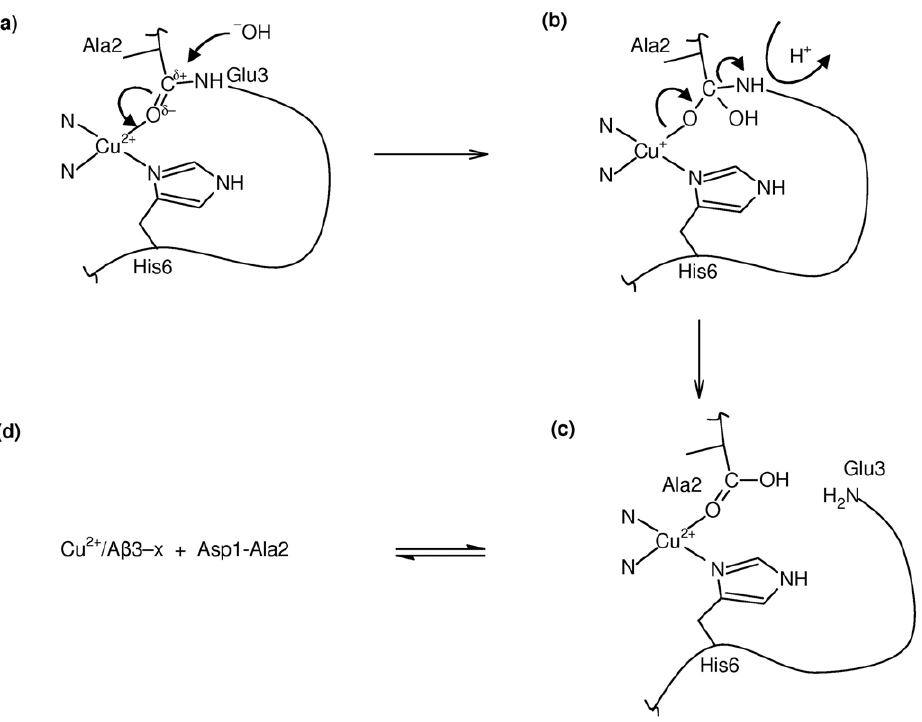
Figure 8. Postulated mechanism of Cu 2 + -promoted amide hydrolysis leading to A b truncation at Glu3. (a) Coordination of Ala2 (component II coordination mode) polarises the carbonyl carbon, allowing nucleophilic attack by OH 2 , leading to (b) the formation of a tetrahedral intermediate (TI), possibly via a Cu + oxidation state (alternatively, the coordination may be Cu 2 + –O 2 –C–); (c) subsequent breakdown of the TI involving cleavage of the amide bond and protonation of the leaving amide. This latter step may involve the participation of a nearby amino acid side chain for proton transfer to the leaving amide nitrogen. Additional transient interactions with other cofactors in vivo could be required to promote formation, and importantly the breakdown, of the TI. Other biological nucleophiles may also be considered in step (a), such thiols (eg. glutathione, L- homocysteine) or a serine hydroxyl group. The geometry of the coordinating ligands is drawn schematically only.